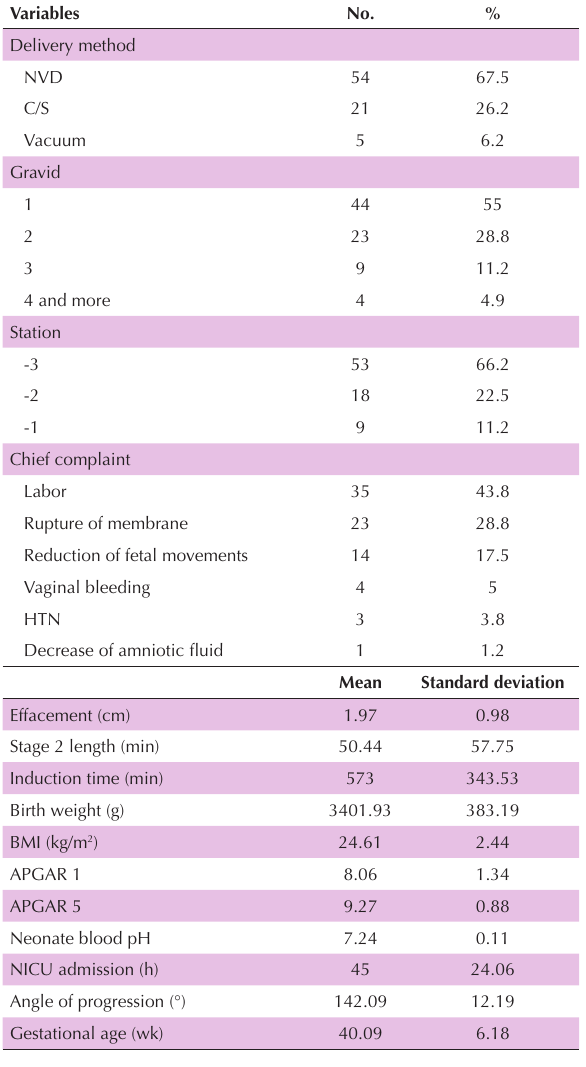
Table 1. Descriptive data of study variables Variables No.